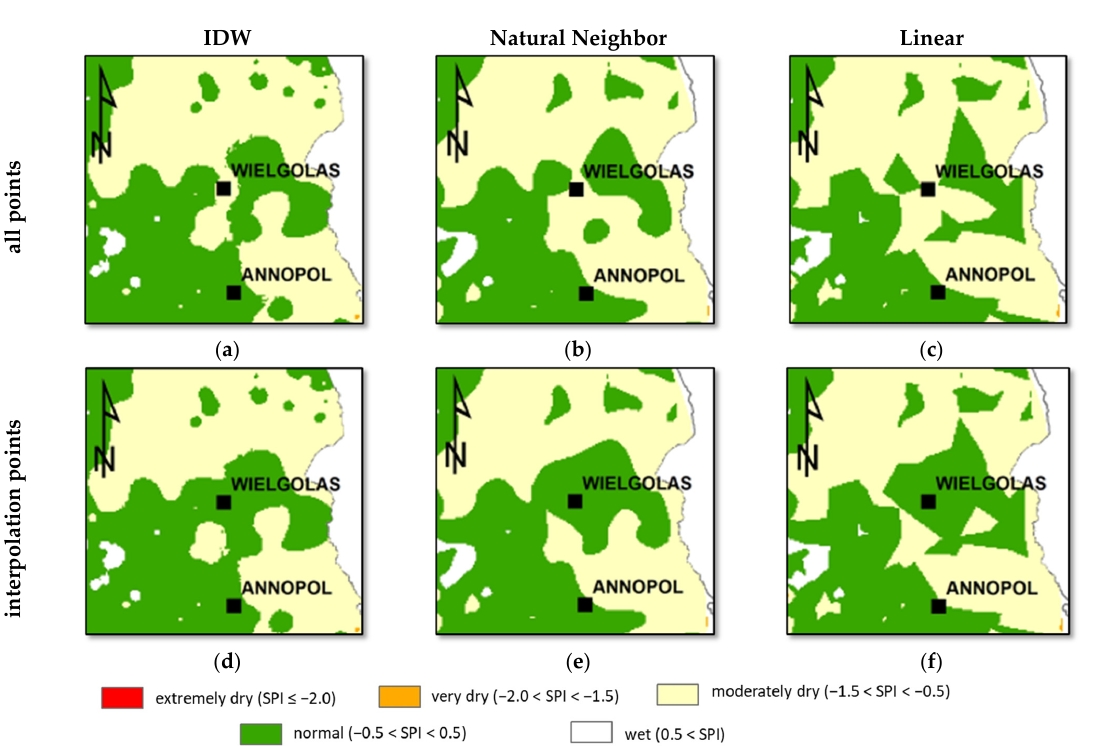
Figure 11. Illustration of sensitivity of interpolation to the point removal. The analyzed period is June 2015. The top row ( a – c ), presents the results of the interpolation with all meteorological stations included. The bottom row ( d – f ) presents the results without control stations. ( a , d ) Inverse Distance Weighted, ( b , e ) Natural Neighbor, ( c , f ) linear interpolation.